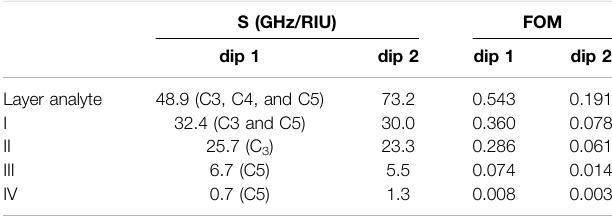
TABLE 2 | Summary of sensitivity and FOM for the simulated LC and dipole resonances. S (GHz/RIU)